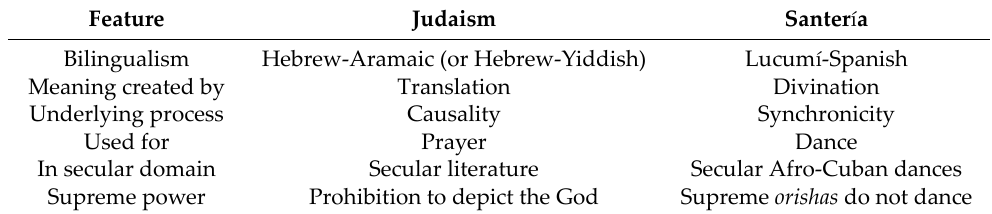
Table 1. Comparison of Judaism and Santer í